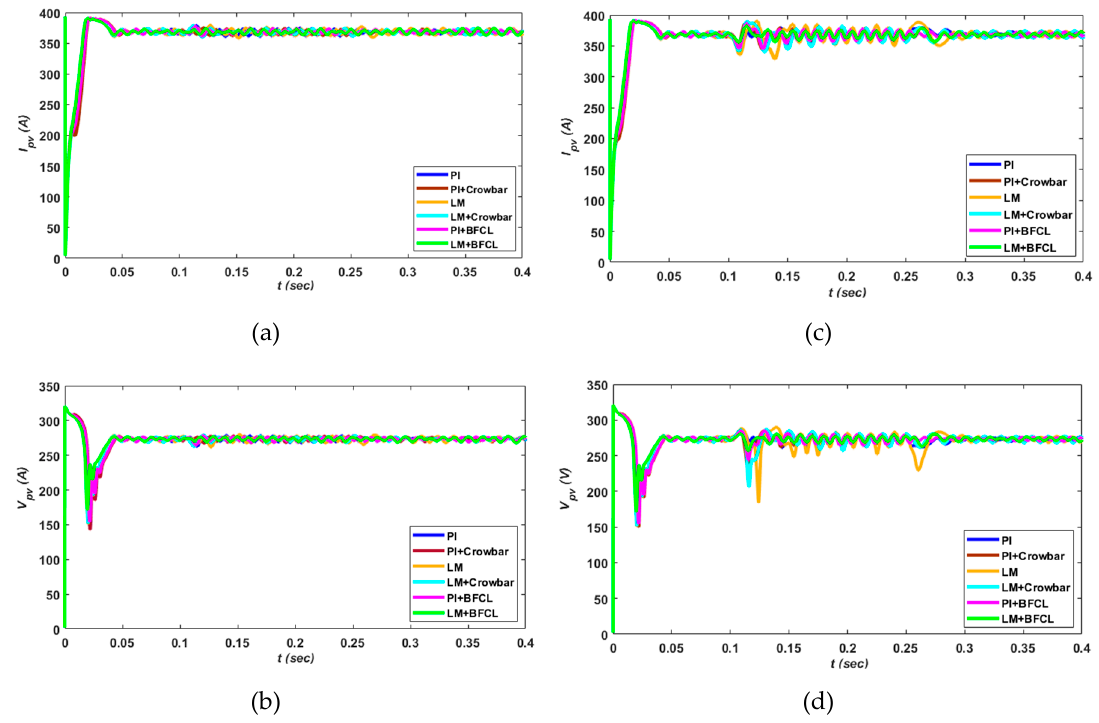
Figure 20. Current and voltage of PV array during P-G 20 ( a, b ) and P-P fault 20 ( c, d ) at PCC.